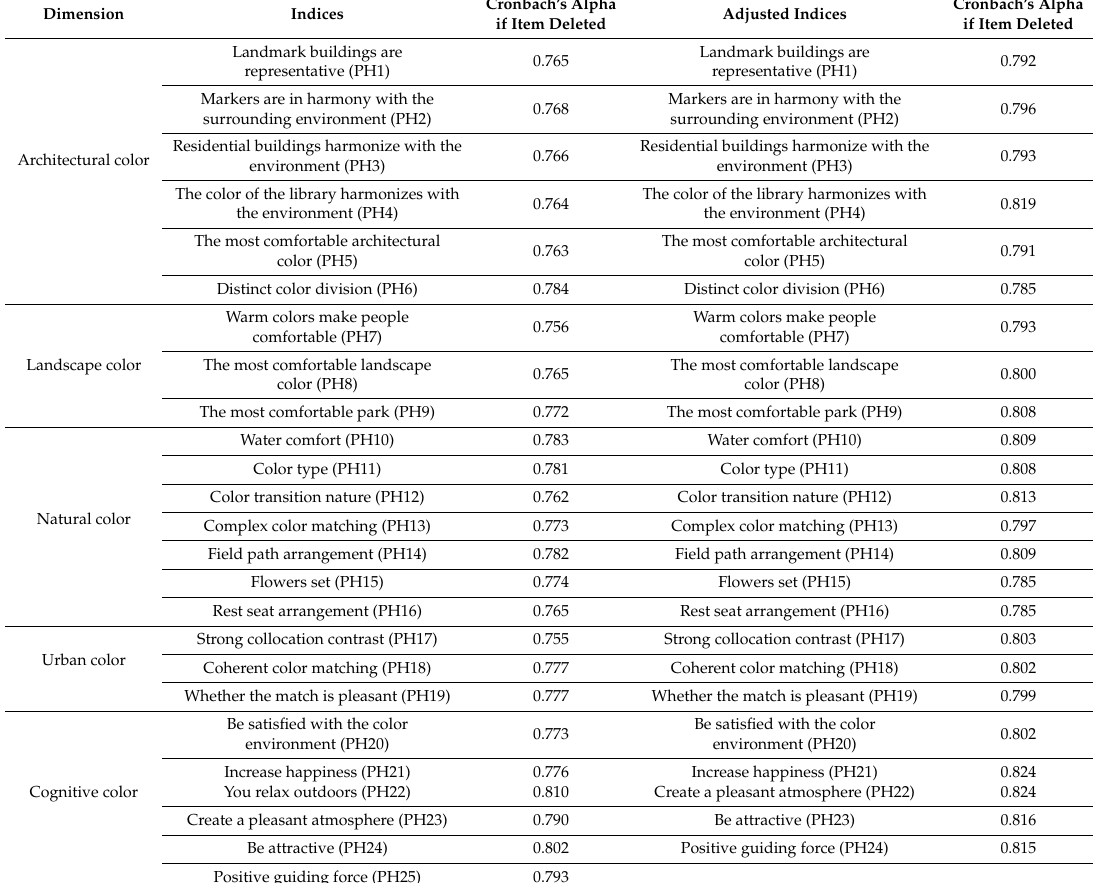
Table 3. Questionnaire indices and reliability test list.